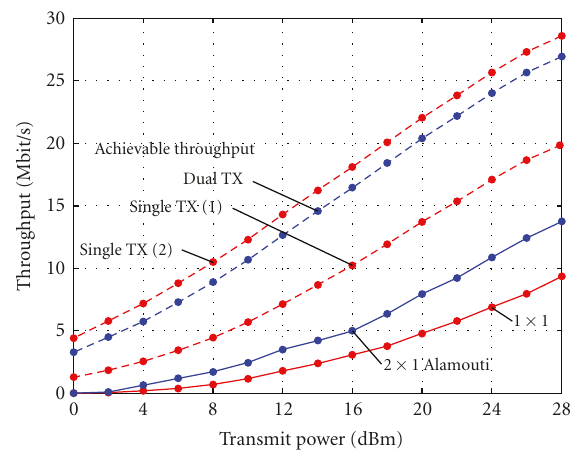
Figure 8: Scenario 2, measured (solid) and achievable (dashed) data throughput in the NLOS outdoor-to-outdoor scenario using one receive antenna. The largest transmit power corresponds to a receive SNR of about 24 dB.